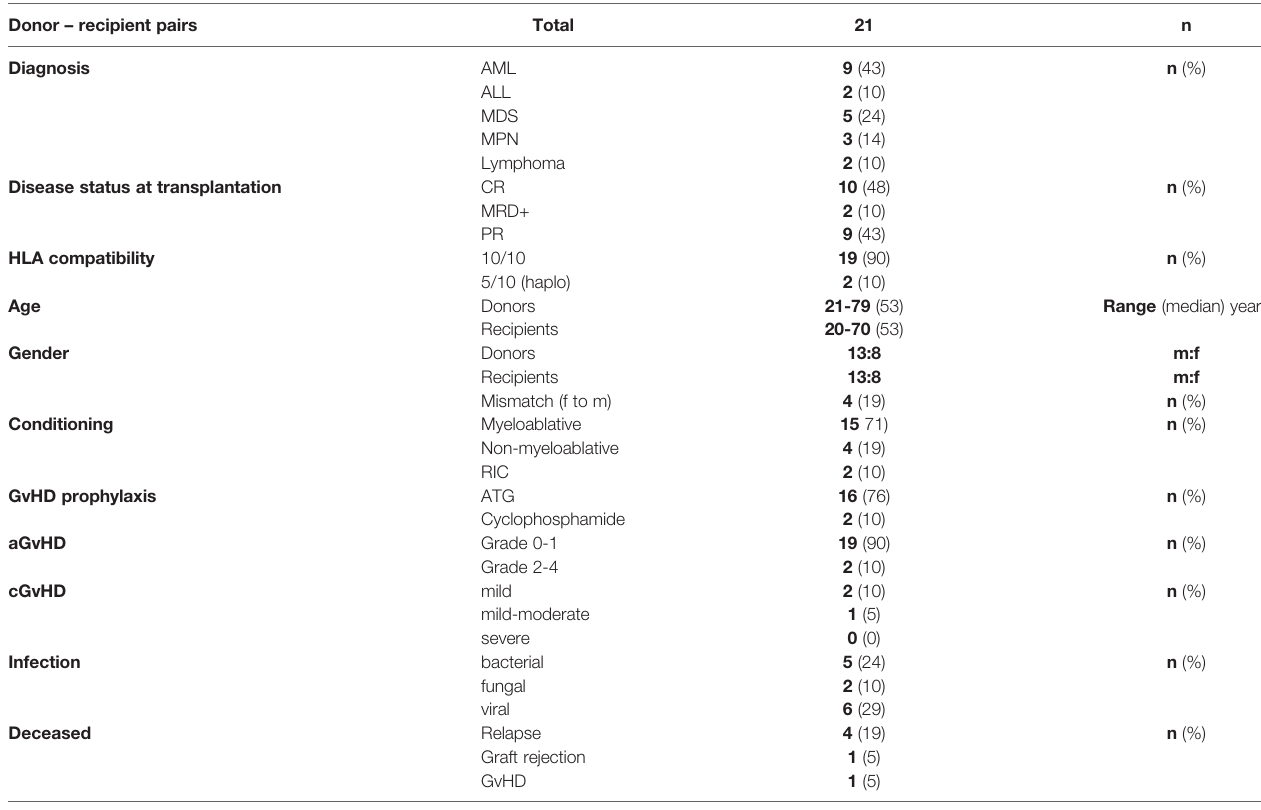
TABLE 1 | Clinical